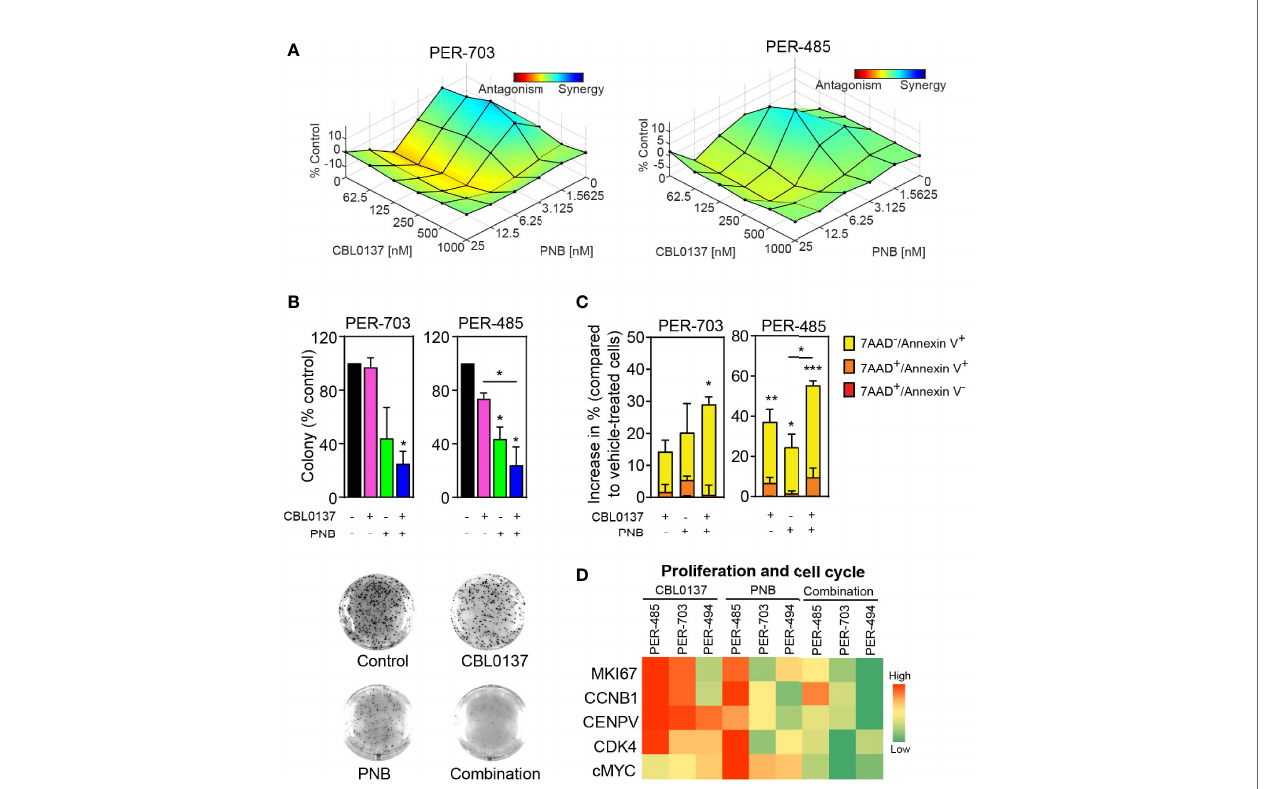
FIGURE 2 | The combination of CBL0137 and panobinostat (PNB) kills KMT2A-r leukemia cells. (A) Synergy distribution according to Bliss and visualized by Combene fi t. Cells were treated with increasing doses of CBL0137 combined with panobinostat in a 6 × 6 matrix format and cell viability was measured by resazurin reduction-based assays after 5 days (n=2). (B) Soft-agar colony assays with infant KMT2A-r leukemia cells treated with CBL0137 (PER-703: 0.2 µM; PER-485: 0.3 µM) and/or PNB (PER-703: 4 nM; PER-485: 6 nM) for 10 to 14 days. Bar graphs represent the mean % colonies relative to vehicle-treated cells +/- SEM of two independent biological replicates. Representative images of PER-703 treatment wells are shown under the graph. (C) Mean percentage increase in annexin V + PER- 485 and PER-703 cells (includes annexin V + /7AAD - and annexin V + /7AAD + cells) relative to vehicle-treated cells after treatment with CBL0137 (0.3 µM), PNB (10 nM) or the combination for 24 hours. Graphs depict mean ± SE of at least three independent experiments. Statistical analyses were performed for the sum of all annexin V + cells (7AAD - and 7AAD + ). (D) Heatmap of mRNA expression of genes in treated KMT2A-r leukemia cells relative to vehicle-treated cells as determined by qRT- PCR. Statistical data displayed at the top of a bar in the graphs correspond to comparisons with control cells. Statistical signi fi cance was determined by one-way ANOVA. Asterisks represent signi fi cance levels of P values: *P < 0.05; **P < 0.01; ***P <